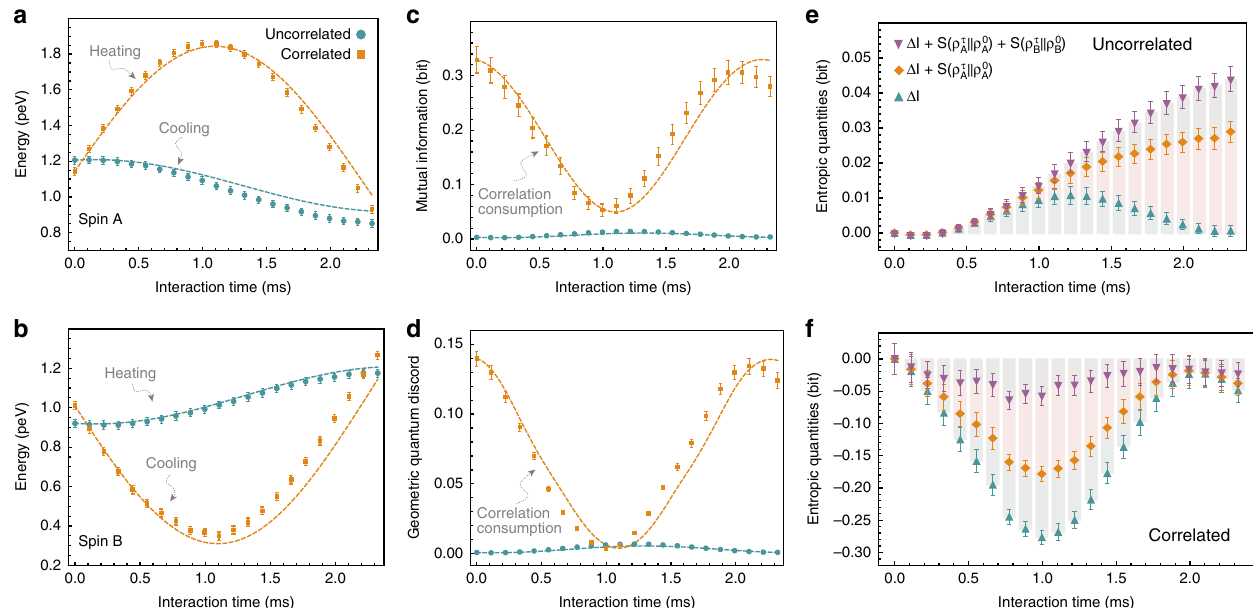
Fig. 2 Dynamics of heat, correlations, and entropic quantities. a Internal energy of qubit A along the partial thermalization process. b Internal energy of qubit B. In the absence of initial correlations, the hot qubit A cools down and the cold qubit B heats up (cyan circles in panel a and b ). By contrast, in the presence of initial quantum correlations, the heat current is reversed as the hot qubit A gains and the cold qubit B loses energy (orange squares in panel a and b ). This reversal is made possible by a decrease of the mutual information c and of the geometric quantum discord d . Different entropic contributions to the heat current (5) in the uncorrelated e and uncorrelated f case. Reversal occurs when the negative variation of the mutual information, Δ I ( A : B ), (cid:1) (cid:3) (cid:1) (cid:3) k ρ k ρ compensates the positive entropy productions, S ρ τ and S ρ τ , of the respective qubits. The symbols represent experimental data and the A B A B dashed lines are numerical simulations. Error bars were estimated by a Monte Carlo sampling from the standard deviation of the measured data (Supplementary theoretical simulations (dashed lines). Small discrepancies seen as time increases are mainly due to inhomogeneities in the control fi elds.